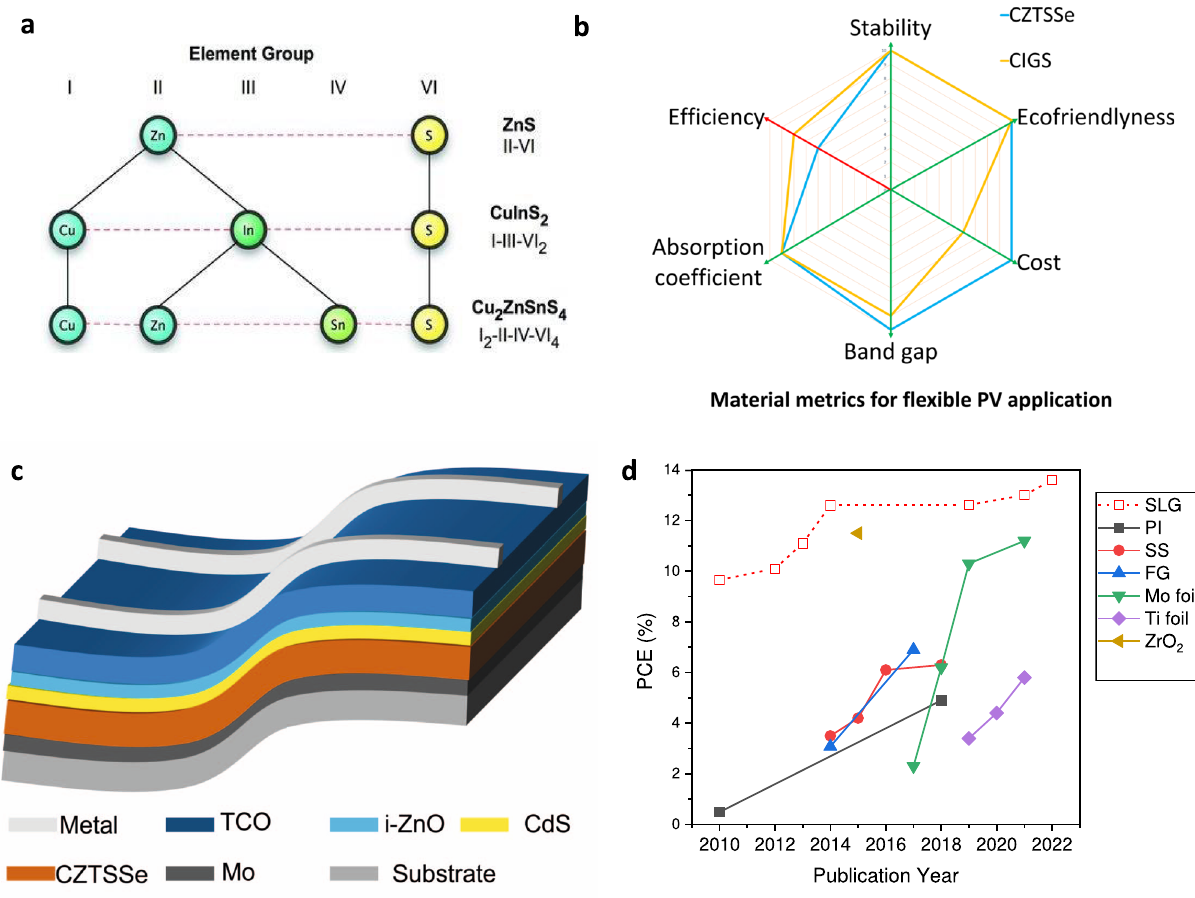
Fig. 1 Materials and device structure of fl exible CZTSSe thin- fi lm solar cells. a the thermodynamically favorable kesterite structure of CZTSSe. Reproduced with permission 16 . Copyright 2012, Wiley-VCH. b Material metrics of CZTSSe and CIGS for fl exible PV application. c Schematic diagram of the typical device structure of fl exible CZTSSe thin- fi lm solar cells. d Evolution of record ef fi ciencies of CZTSSe thin- fi lm solar cells fabricated on various fl exible substrates and on soda lime glass (SLG). (PI polyimide, SS stainless steel, FG fl exible glass) The data are picked up from Table